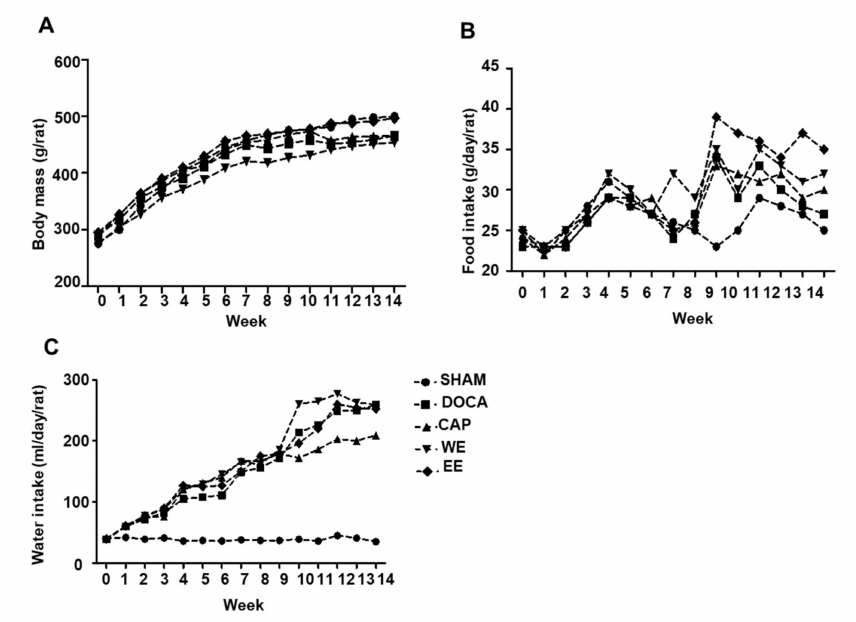
Figure A1. Effects of administration of water extract (WE) and ethanol extract (EE) of L. rhamnosus AC1-fermented soymilk on the body weight ( A ), food intake ( B ), and water intake ( C ) in DOCA-salt hypertensive rats. Data are presented as means ± SEM ( n =